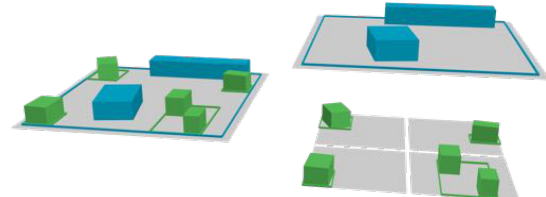
Figure 1: The bounding box hierarchy (left) and an exploded view of it (right).